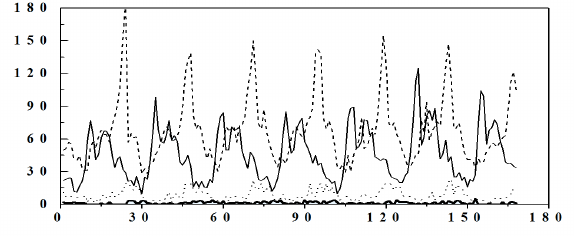
Figure 7. Measured vehicle load.